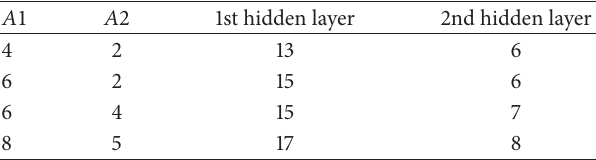
Table 14: The number of neurons in hidden layers of neural